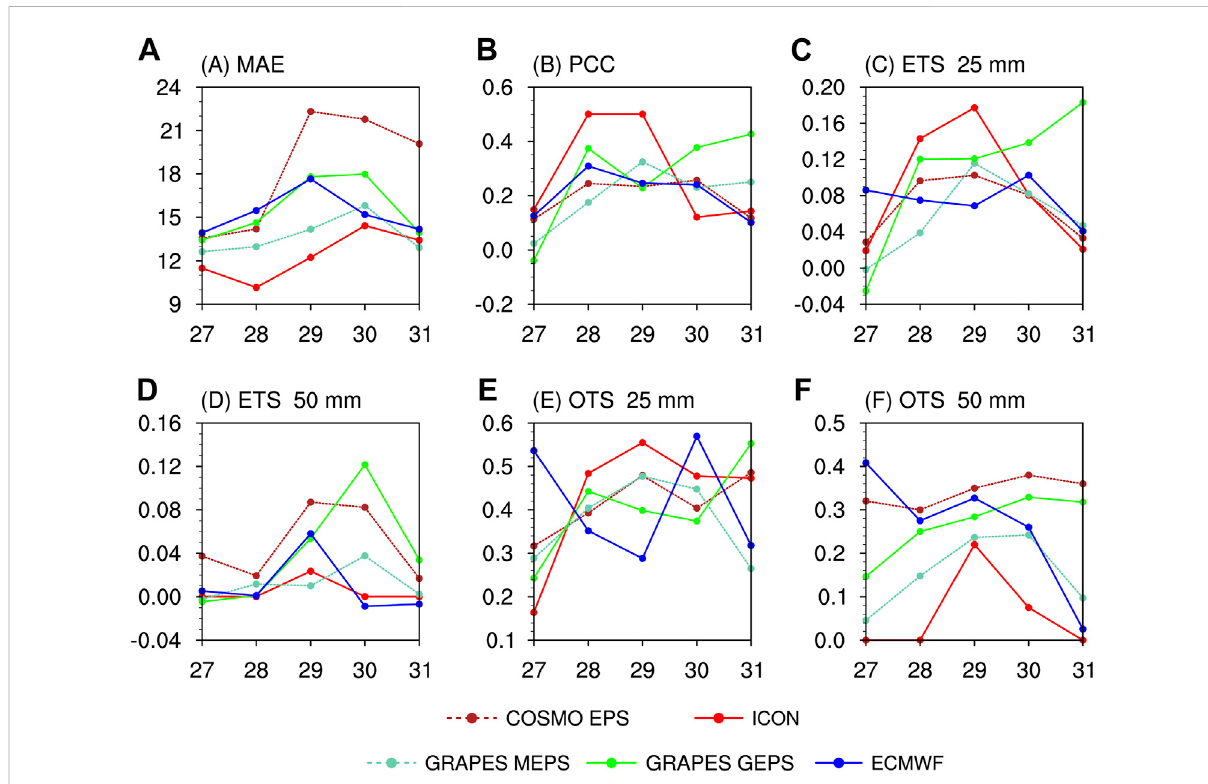
FIGURE 5 Gridpoint-based and object-based evaluations for daily accumulated precipitation obtained from different models during the period of 27 – 31 August 2018. (A) MAE (unit: mm); (B) PCC; (C,D) ETS for precipitation exceeding 25 and 50 mm; (E,F) OTS for precipitation exceeding 25 and 50